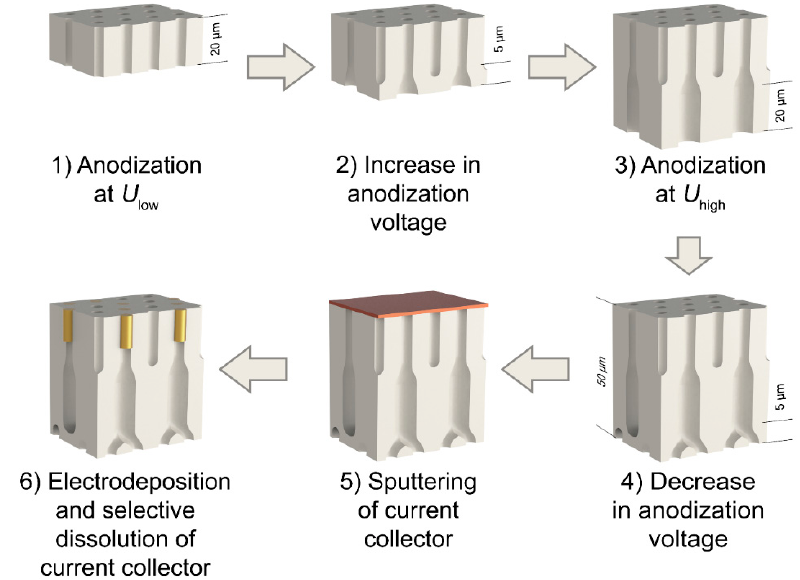
Figure 1. The scheme of the preparation of metal / anodic alumina nanocomposites with controlled fraction of the filled pores.